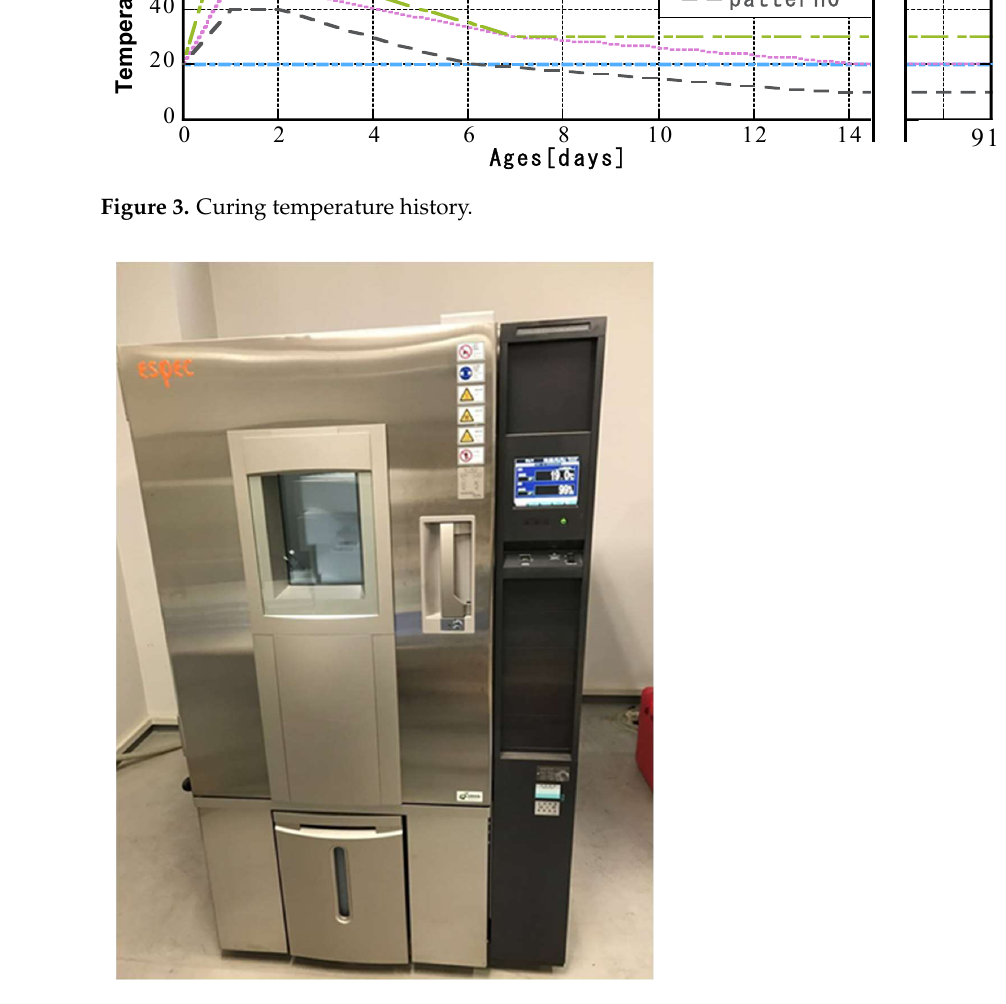
Figure 4. Thermostat machine for sample curing.